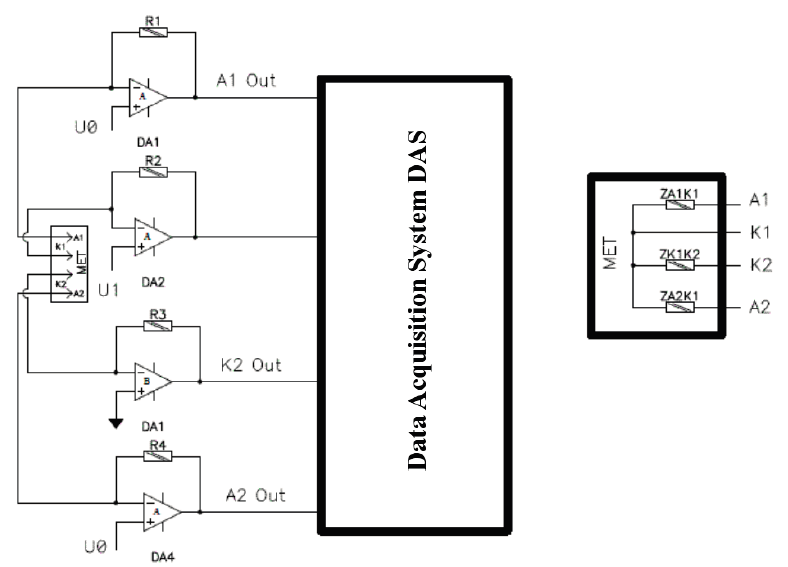
Figure 2. Installation diagram and equivalent electric MET scheme (insertion) for the measurement of molecular electronic angular motion transducer impedance.